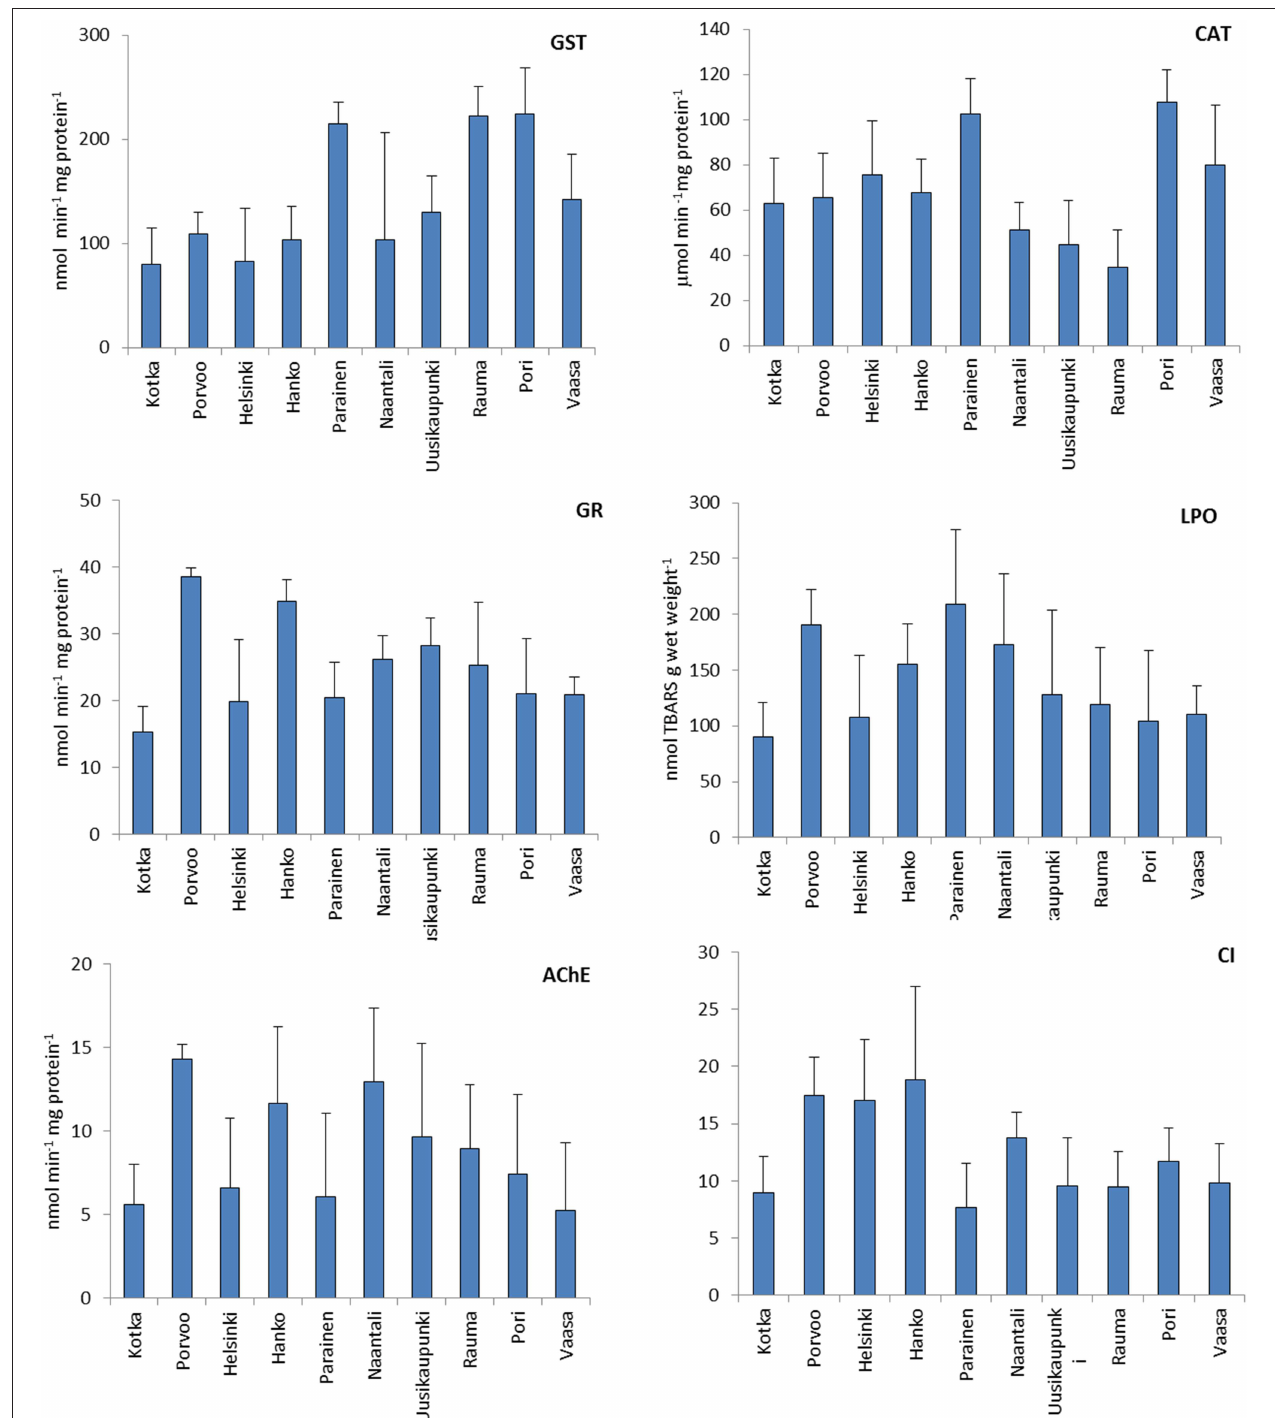
FIGURE 5 | Biomarkers (mean ± SD) measured in caged mussels from the study sites. GST, glutathione S -transferase; CAT, catalase (CAT); GR, glutathione reductase; LPO, lipid peroxidation; AChE, acetylcholinesterase; CI, condition index. Statistical significances: see Table 3 .